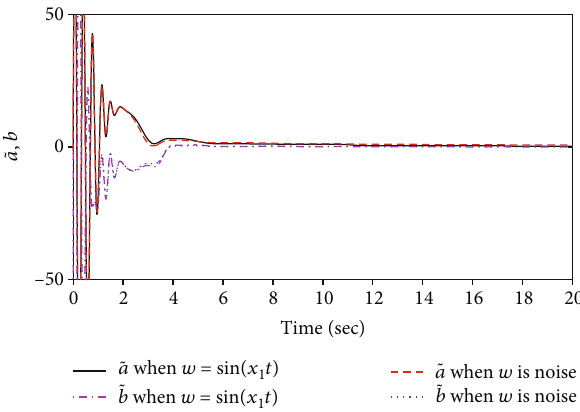
Figure 8: Time response of the parameter estimation errors.